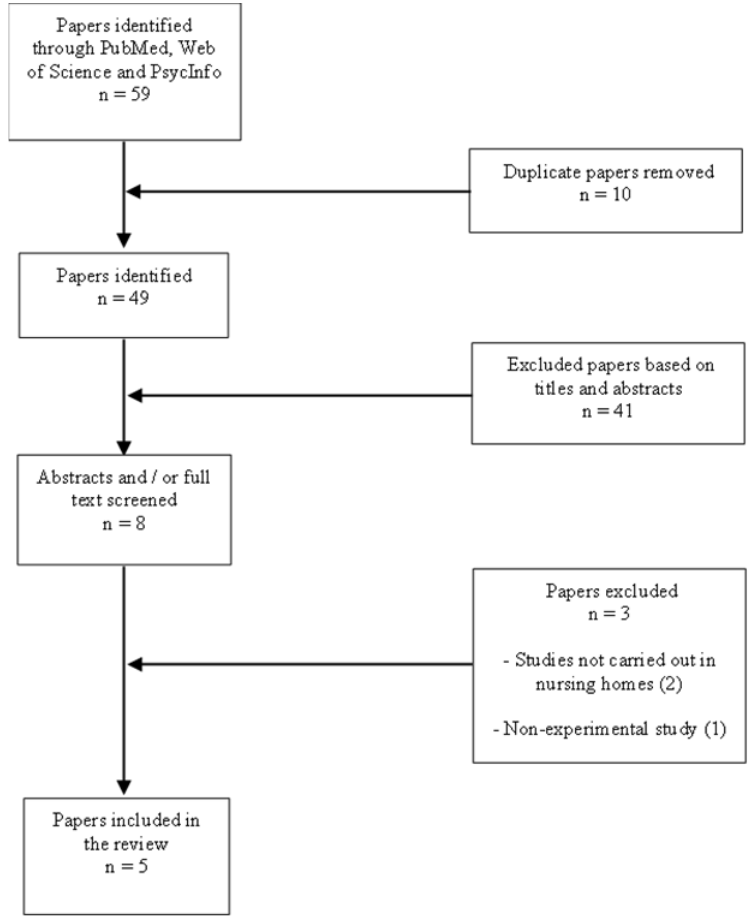
Figure 1. Chart flow of the selection process.